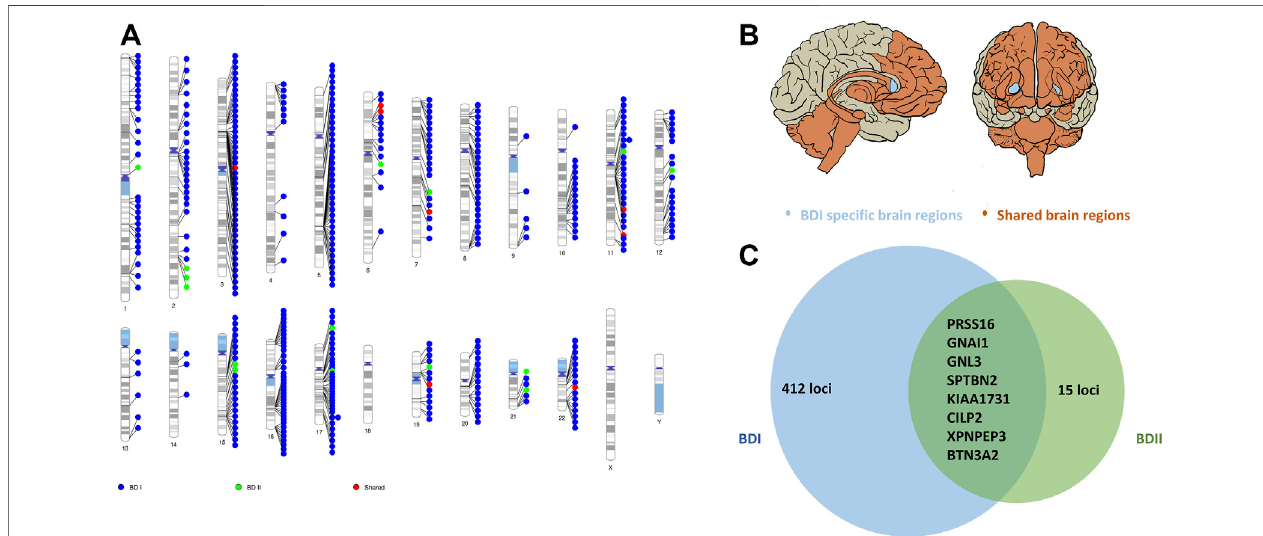
FIGURE3| Sharedandtrait-speci fi ceQTLsofBDIandBDII. (A) Genomicregionsthatarespeci fi ctoBDI(bluepoints),speci fi ctoBDII(greenpoints),andshared (red points). (B) Associated 13 brain regions with BD I and BD II: cortex, frontal cortex, anterior cingulate cortex, caudate, putamen, hypothalamus, amygdala, hippocampus, substantia nigra, cerebellum, cerebellar hemisphere, spinal cord cervical c-1 (orange area), and BD I speci fi c brain region: nucleus accumbens (light blue area). (C) Prioritized genes for shared and trait-speci fi c regions. Genes presented reached signi fi cance (after FDR correction) in the TWAS test and were identi fi ed bytwomethods(FUSIONande-MAGMA).Thenumbersrepresenttrait-speci fi cgenesidenti fi edbyatleastonemethod.Detailsarein SupplementaryTablesS8 – S12 .